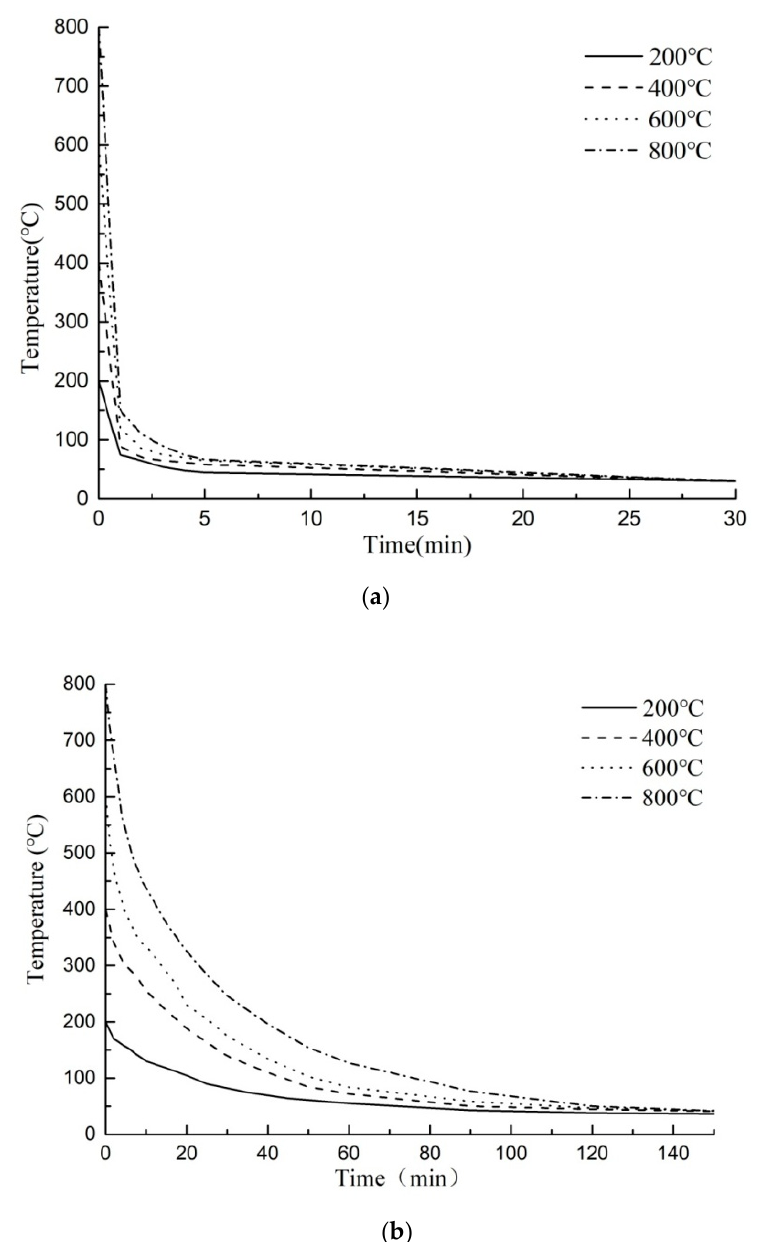
Figure 2. Surface temperature reduction curves of the specimens. ( a ) Temperature reduction curves under water cooling; ( b ) Temperature reduction curves under natural cooling.